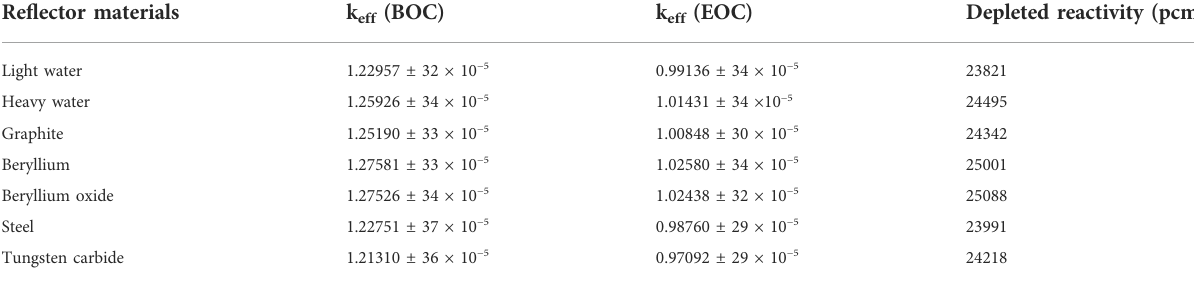
TABLE 4 The k eff values at the beginning and end of the cycle in each of the depletion calculations. Re fl ector